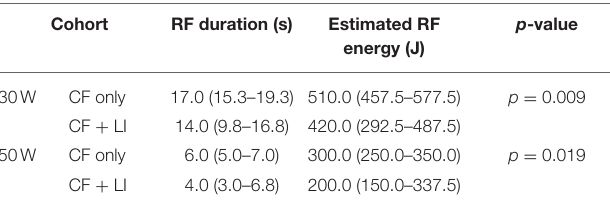
TABLE 2 | RF duration and estimated energy for all LIPV RF applications (median and